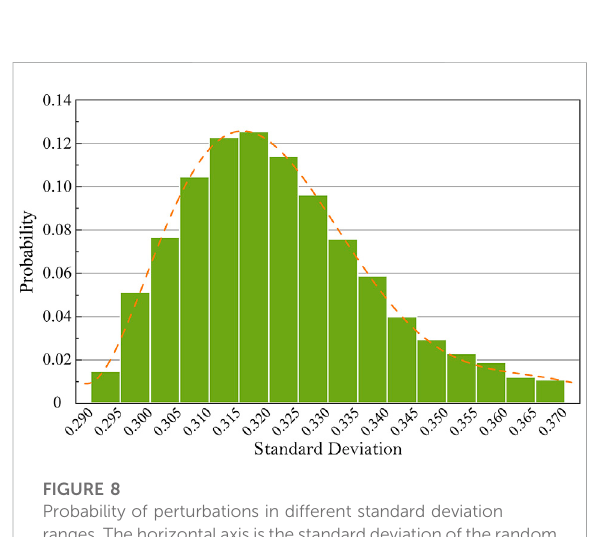
FIGURE 9 Comparison of DPH, WH, and the proposed method in reconstruction quality and speed.